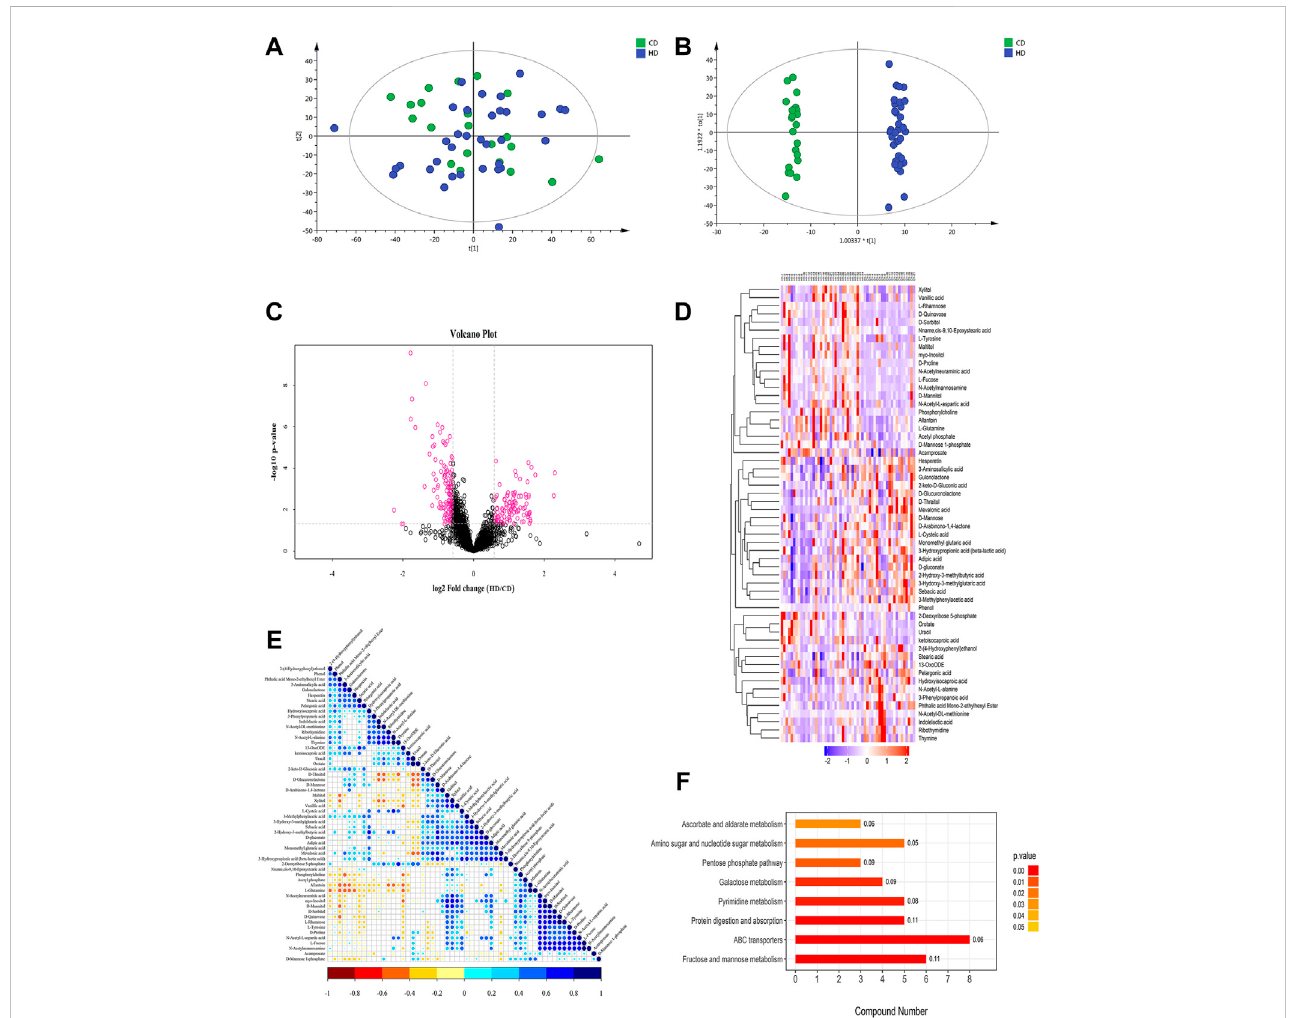
FIGURE 2 Multivariate statisticalanalysis,heat map, clusteranalysis, and metabolic pathways(takepositive ion modeas an example) (A) PCA score chart. (B) OPLS- DA score chart of saliva metabolite analysis in the HD-CD. (C) The volcano map of the differential metabolites in the HD-CD. The red spots in the fi gure indicate the metabolites with |FC| > 1.5 and p < 0.05. These metabolites are the differential metabolites screened by univariate statistical analyses. (D) The resultsofhierarchicalclustering ofmetaboliteschangedsigni fi cantlyinthesample.Red andbluerepresenthigher andlowermetaboliteconcentrations, respectively. The redder the color, the higher the expression amount of the metabolite. The bluer the color, the lower the expression amount of the metabolite. (E) The correlation of metabolites of signi fi cant difference in HD-CD. The color shows the correlation between the two metabolites. Blue dots in the graph indicate positive correlations between metabolites, while red dots indicate negative correlations between metabolites. (F) The KEGG pathway enrichment analysis results in differential metabolites. Histogram color corresponds to p -value, the smaller the p -value, statistically more signi fi cant is the enrichment of the KEGG pathway ( p < 0.05). The X -axis represents the number of signi fi cantly different metabolites were enriched in this pathway, and the value on the histogram is rich